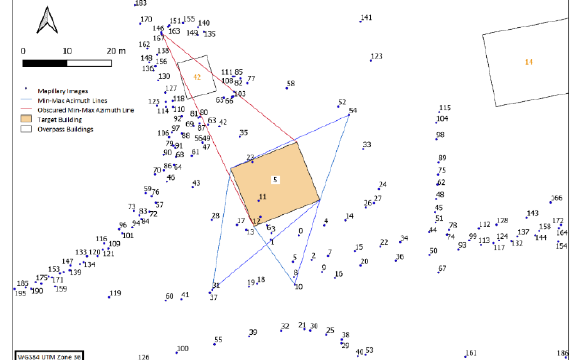
Figure 9. The image 146 obscured by building id: 42, as the minimum and maximum azimuth lines of the target building id: 5 intersect this building, Images of 37, 54 and 10 are not intersecting. (Illustration with only 4 images, the process flow takes all images into consideration)